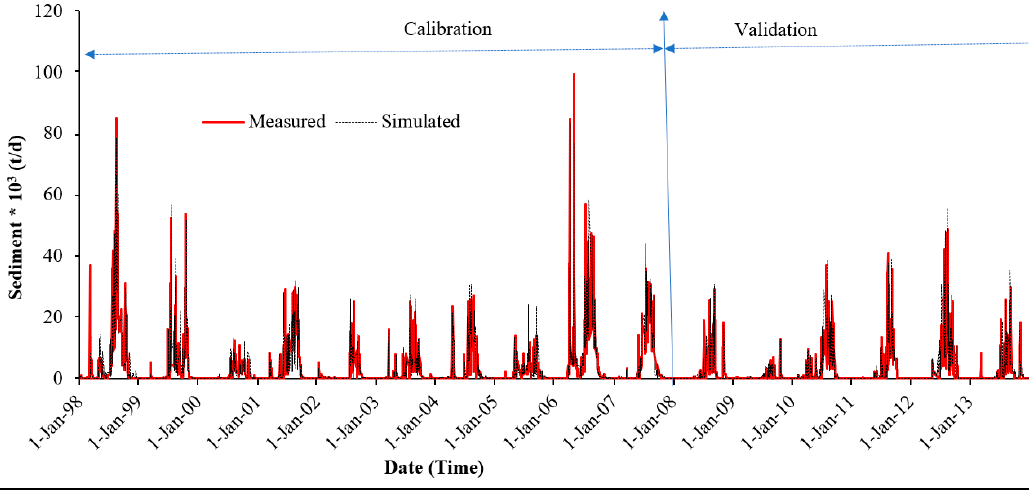
Table 2. Daily measured and simulated sediment yield calibration and validation model performance statistics.